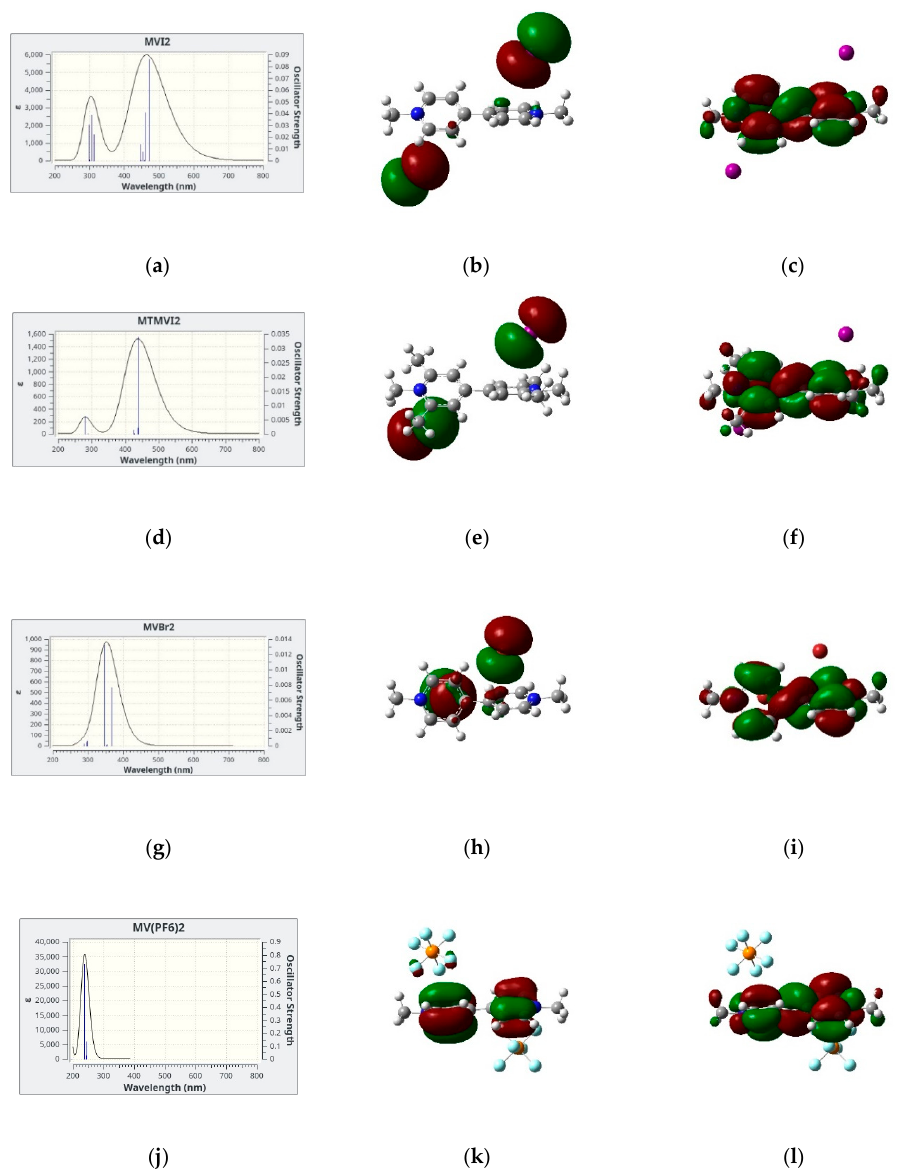
Figure 4. ( a ), ( d ), ( g ), ( j ): Simulated absorption spectra with the underlying vertical transitions: ( b ), ( e ), ( h ), ( k ): HOMOs and ( c ), ( f ), ( i ), ( l ) LUMOs orbitals involved in the CT band of the four systems investigated in dichloromethane.